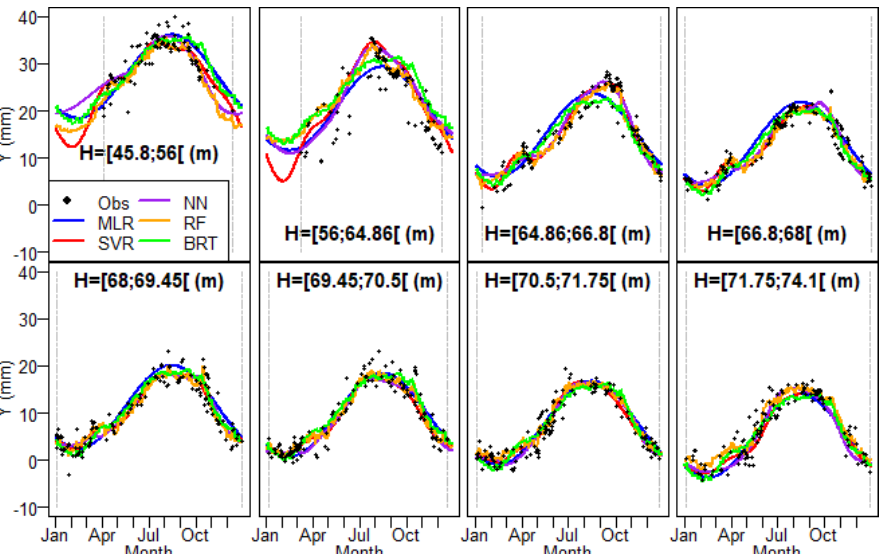
Figure 17. Sensitivity analysis due to the thermal effect for Machine Learning model results based on the training data. The vertical lines are the maximum and minimum measured values obtained during the training